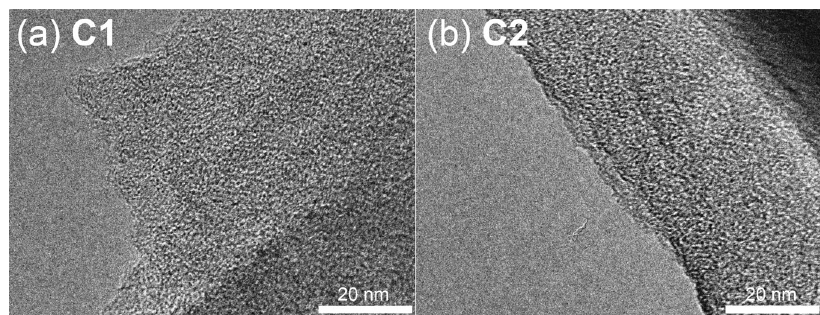
Fig. 3 TEM images. TEM images of porous carbons of a C1 and b C2 than C1 (blue circles), owing to the larger pore size and volume that were developed by the biphenyl moieties. When nitrogen gas was used (Fig. 2c), the powder of C2 adsorbed N 2 (diameter: 3.7 Å, red triangles), but that of C1 did not (blue circles). C2